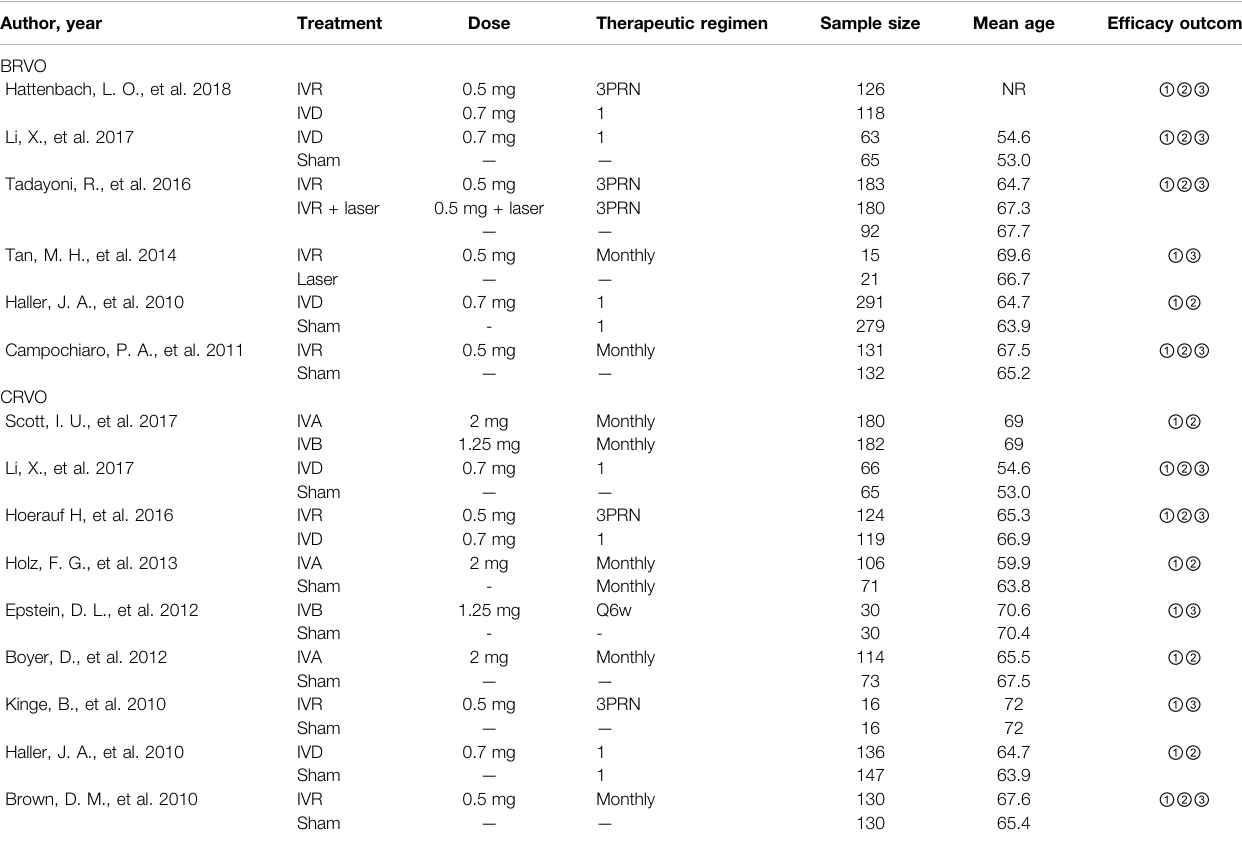
TABLE 1 | Study and patient population characteristics of included studies.